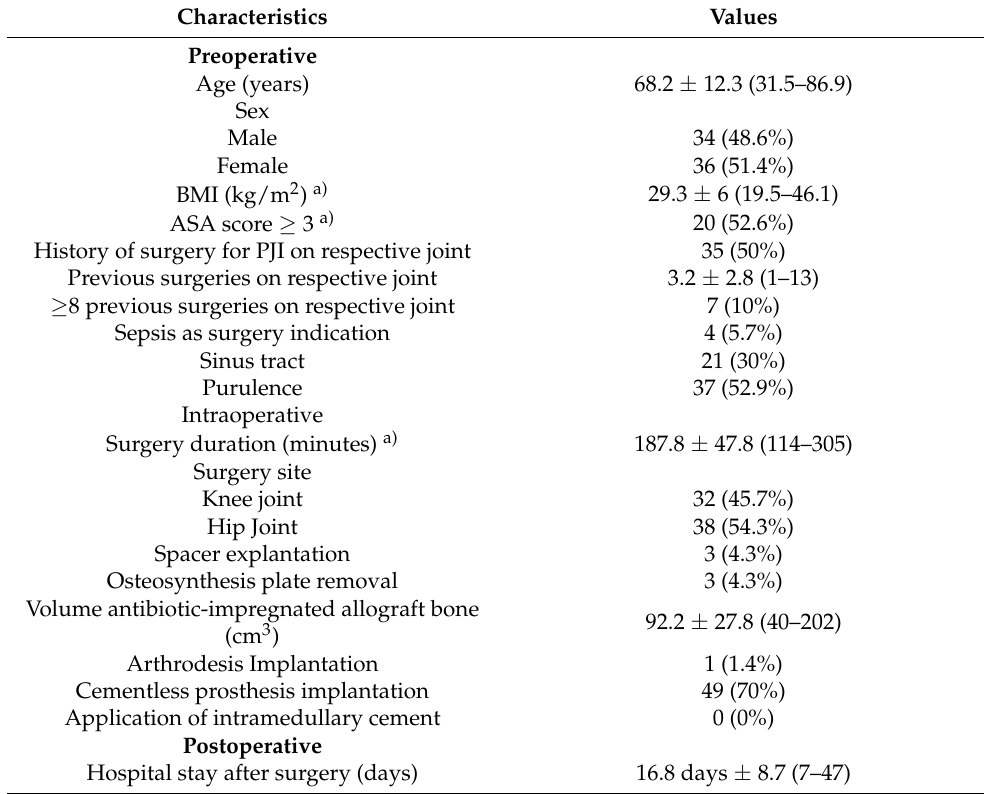
Table 1. Patient characteristics (n =